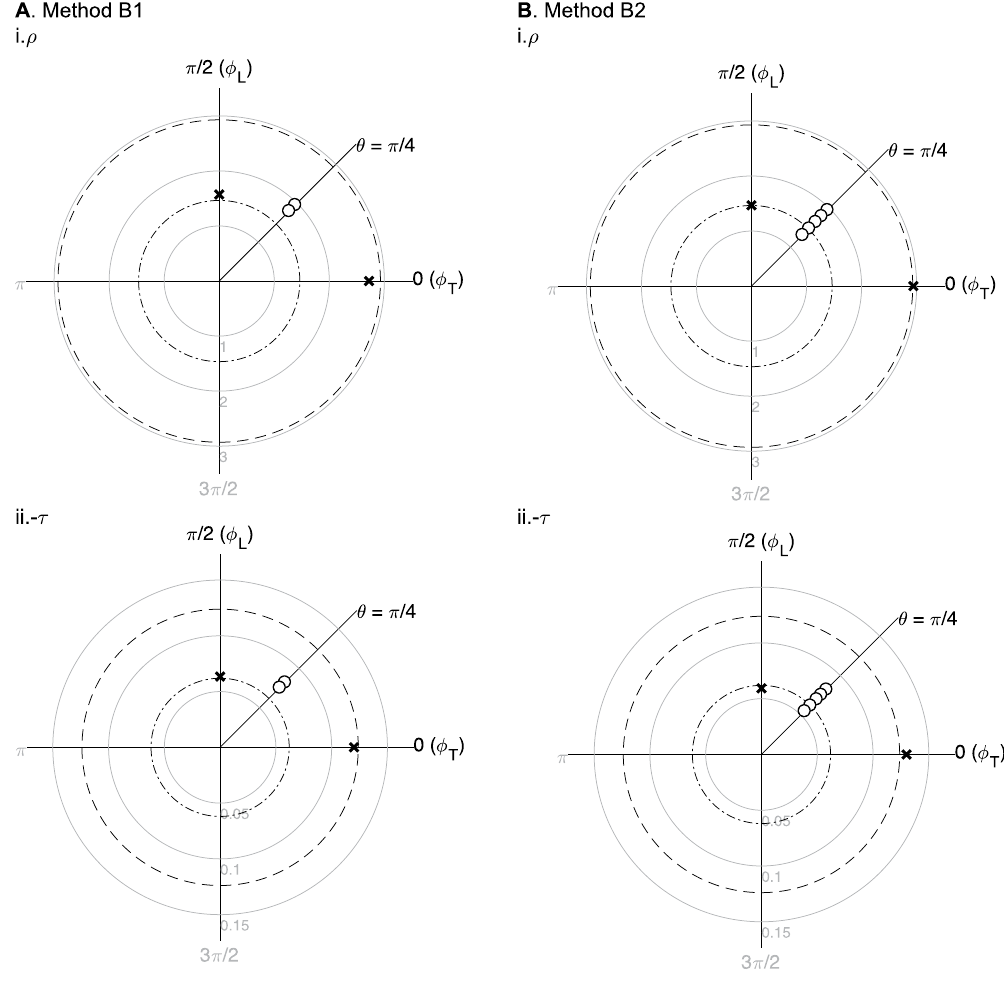
Figure 6. Numerical simulation results using methods B1 ( A ) and B2 ( B ). The estimated impedivity in κ (shown in crosses) were calculated from M = 10 averaged longitudinal (L) and transverse (T) directions ˆ L { ,T} apparent impedivity p ( ) ˆ κ measurements (shown in circles), with n = 1, … , N the number of inter-electrodes’ n a distances and θ = π /4 the measurement angle. Method B1 ( N = 2): ρ = . 1 57 ˆ Ω m, ρ = . 2 73 ˆ Ω m, L T τ = − . ˆ 0 06 ρ = . ˆ Ω m and 2 94 ρ = . ˆ Ω m, τ = − . 0 06 Ω m, ˆ τ = − . 0 12 Ω m; Method B2 ( N = 5): 1 45 Ω m, L T L ˆ L T ˆ τ = − . 0 13 T Ω m. The true longitudinal and transverse resistivity (i) and reactivity (ii) are plotted in dash-dot and dashed circumferences,